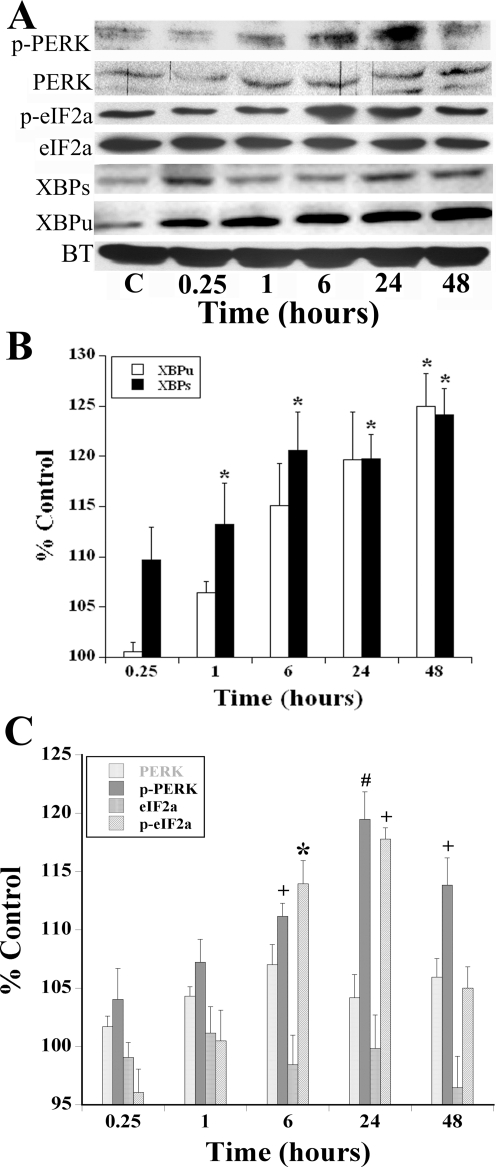
Endoplasmic Reticulum UPR pathway proteins are up-regulated by HIV-1 Tat.A, The treatment of cortical neurons with Tat (8 nM) resulted in the increase in activation of several UPR proteins, including either phosphorylated species or an increase in the active protein. There was an increase in p-PERK, eIF2α, XBPu and XBPs levels of protein in response to Tat exposure. The panels depicting p-PERK, PERK, p-eIF2a, eIF2a and α-tubulin (AT) are from one experimental replicate while the panels depicting XBPs, XBPu are from another experiment. Expression of AT remained invariant after exposure to Tat for all experimental replicates. B, Using densitometry, the relative expression of each of the UPR proteins were examined with all bands normalized to ΑΤ to demonstrate that equal amounts of protein were loaded into each lane. The relative abundance of XBP species are shown in Panel B and PERK and eIF2α species are shown in Panel C. The phosphorylated PERK and eIF2α proteins increased to 119% and 117% control respectively when exposed to Tat for 24 hours (N = 7, #, p<0.01; +, p<0.005). Both XBPu and XBPs levels demonstrated a similar increase in concentrations during the described time course (n = 6; *, p<0.05).